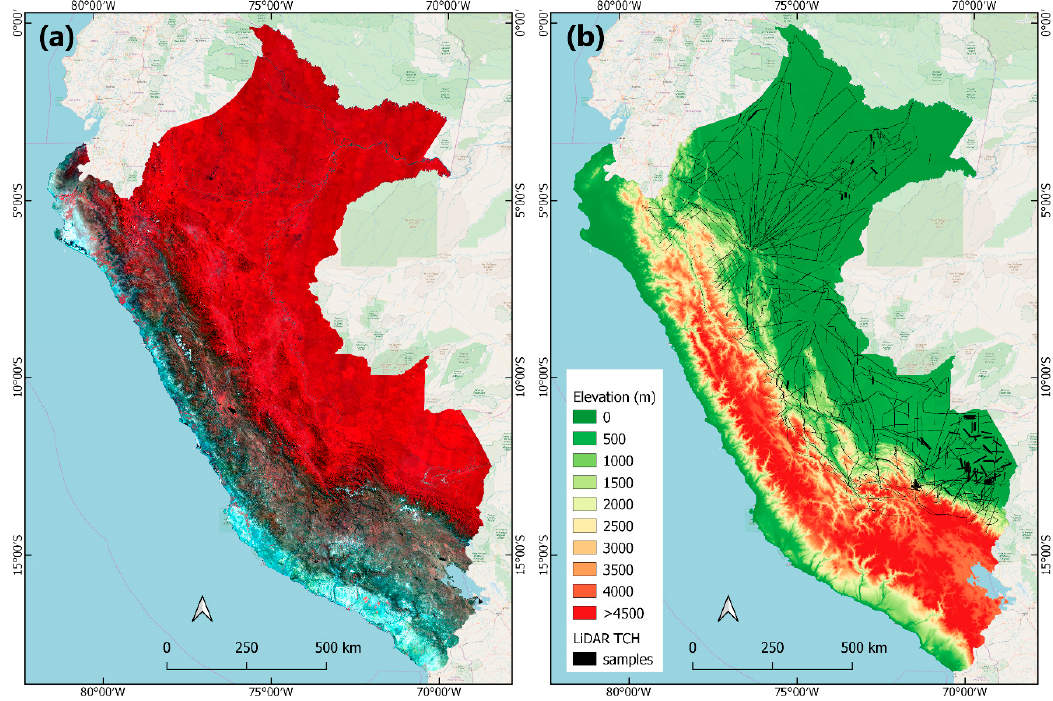
Figure 1. ( a ) The source data used were a 4-band Planet Dove normalized mosaic, shown in false color, together with ( b ) Shuttle Radar Topography Mission (SRTM) elevation data. Features derived from these two data sets are used to estimate ( b ) top-of-canopy height (TCH) as measured by the Global Airborne Observatory (GAO) light detection and ranging (LiDAR) surveys, shown in black paths.